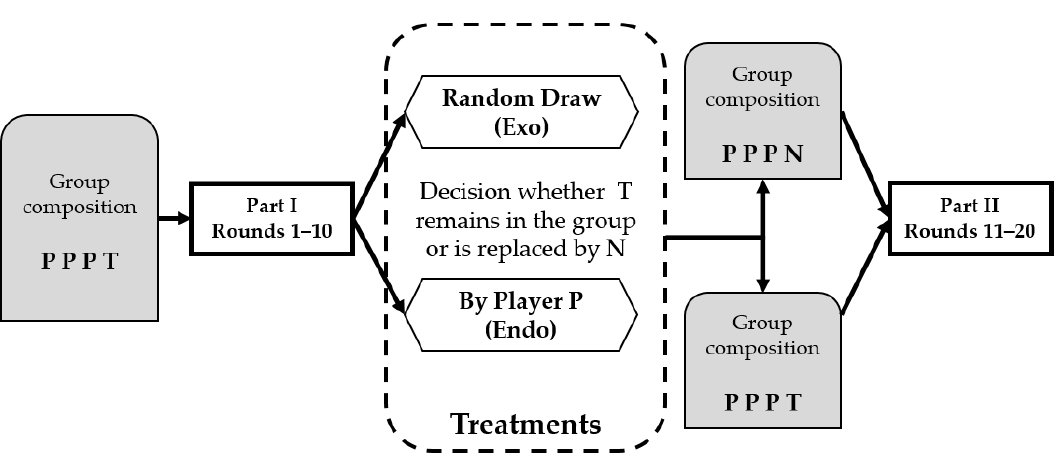
Figure 1. Experimental design. Notation: P —permanent group member, T —temporary group member, N —newcomer in a group.